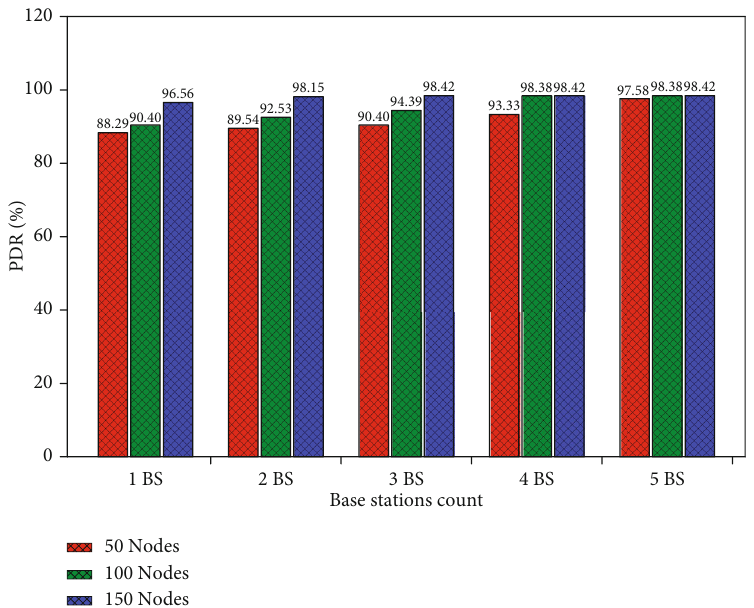
Figure 11: PDR versus the number of base stations in the region.